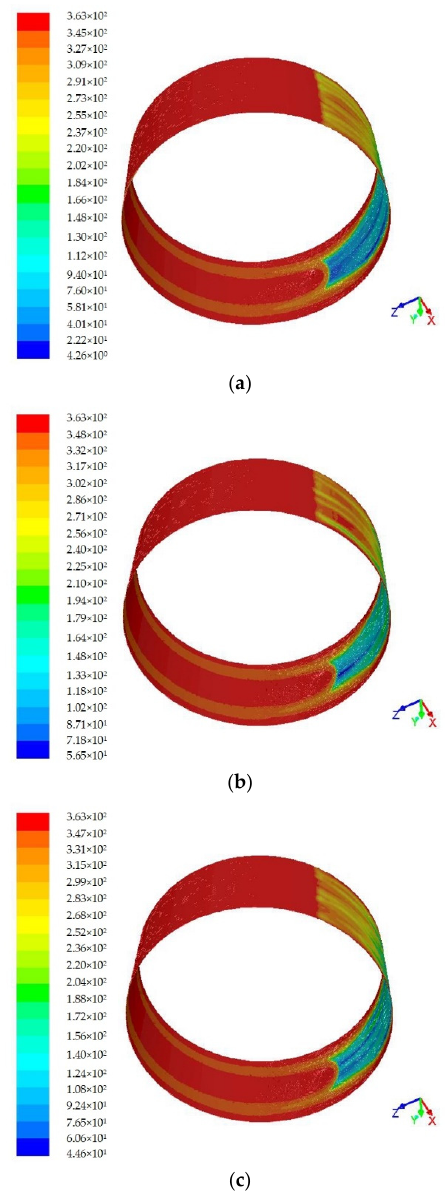
Figure 9. Oil film temperature distribution at different speeds of ( a ) 800 rpm, ( b ) 900 rpm and ( c ) 1000 rpm.